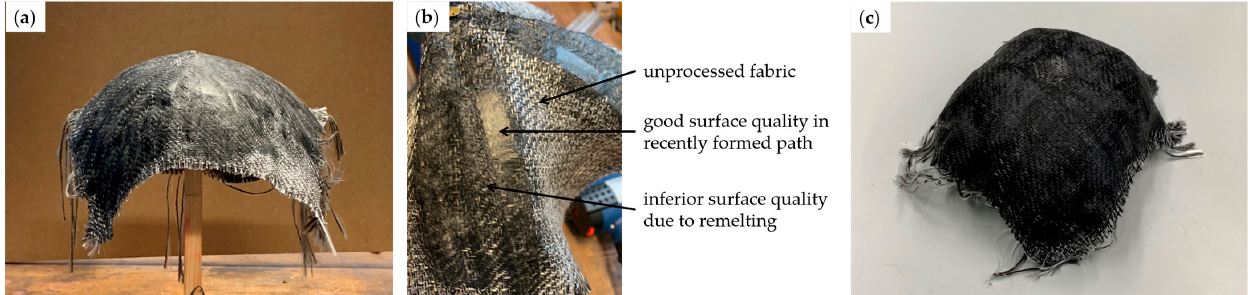
Figure 18. ( a ) Generated hemisphere from commingled thermoplastic weave using a 2D quarter circle and a roller tool; ( b ) Surface quality in an intermediate forming step; ( c ) Generated hemisphere using two roller tools.